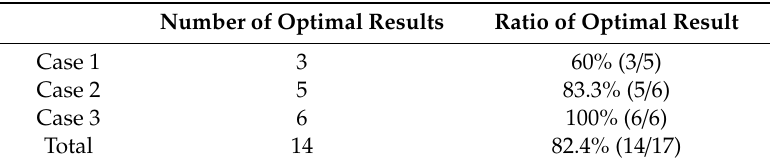
Table 11. Statistics of the optimal results found by